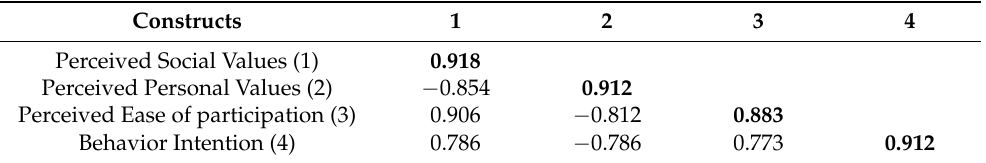
Table 5. Discriminant validity analysis.